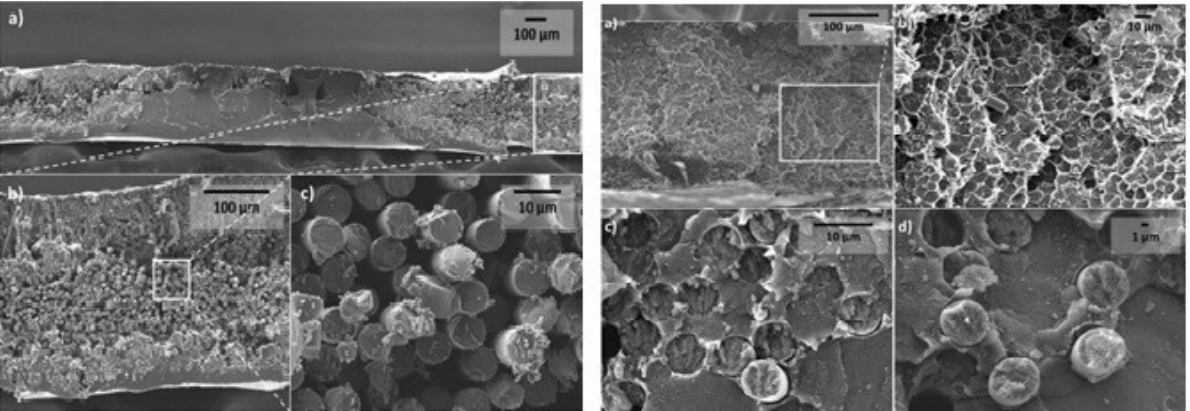
Figure 8. Fracture surfaces of AgNWs modified CF/PEKK laminates fabricated by film stacking method showing poor matrix impregnation with voids ( left ) and powder impregnation method showing improved matrix impregnation with no voids ( right ) at different magnifications (reprinted with permission) [52].